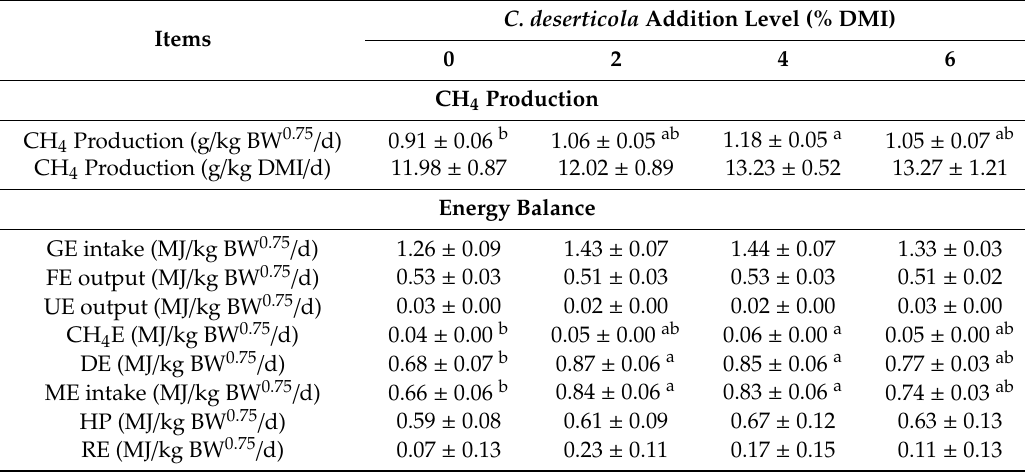
Table 3. E ff ect of C. deserticola addition on methane production, energy balance, and energy utilization e ffi ciency (mean ±